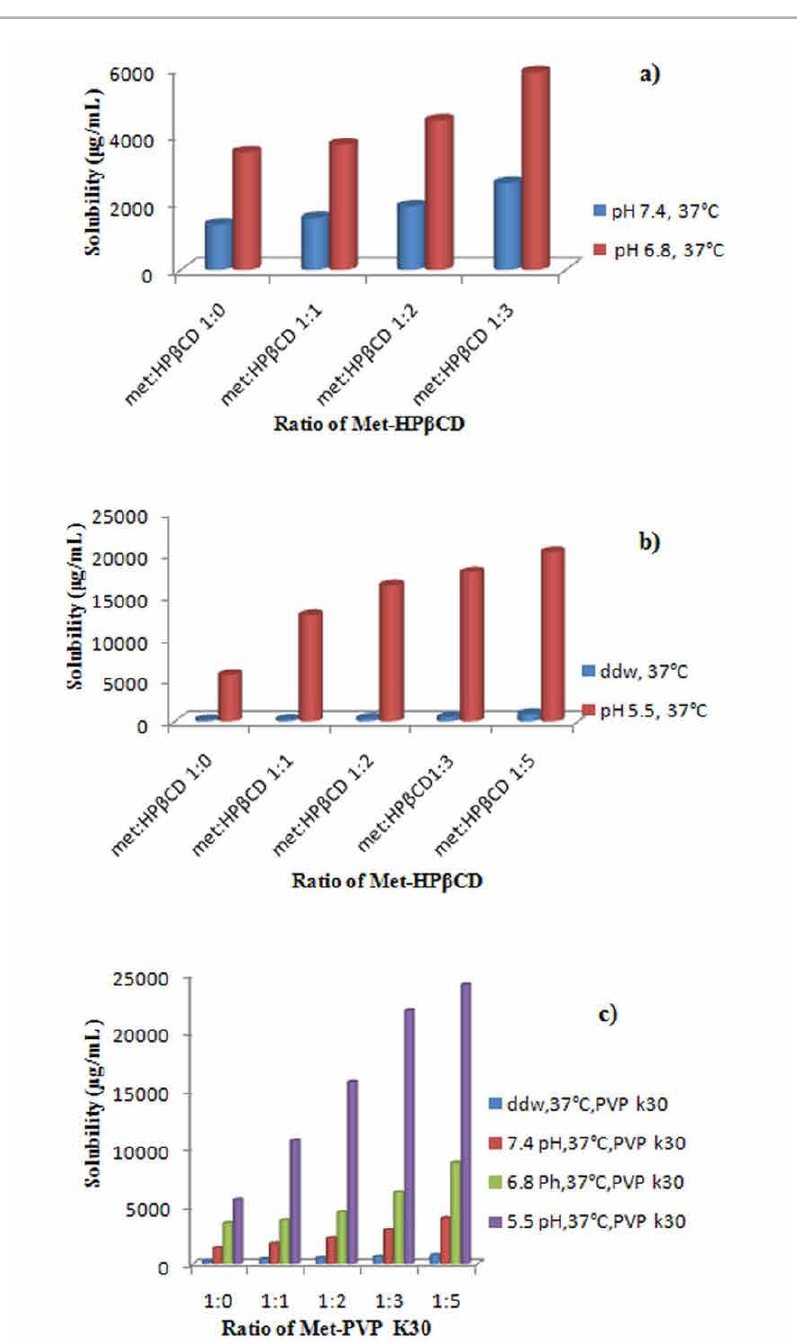
FIGURE 2 – Aqueous solubility diagram of a) Met-HPβCD SD in pH 7.4 and 6.8; b) Met-HPβCD SD in DDW and pH 5.5; c) Met-PVP K30 SD in DDW, pH 7.4, pH 6.8 and pH 5.5at 37